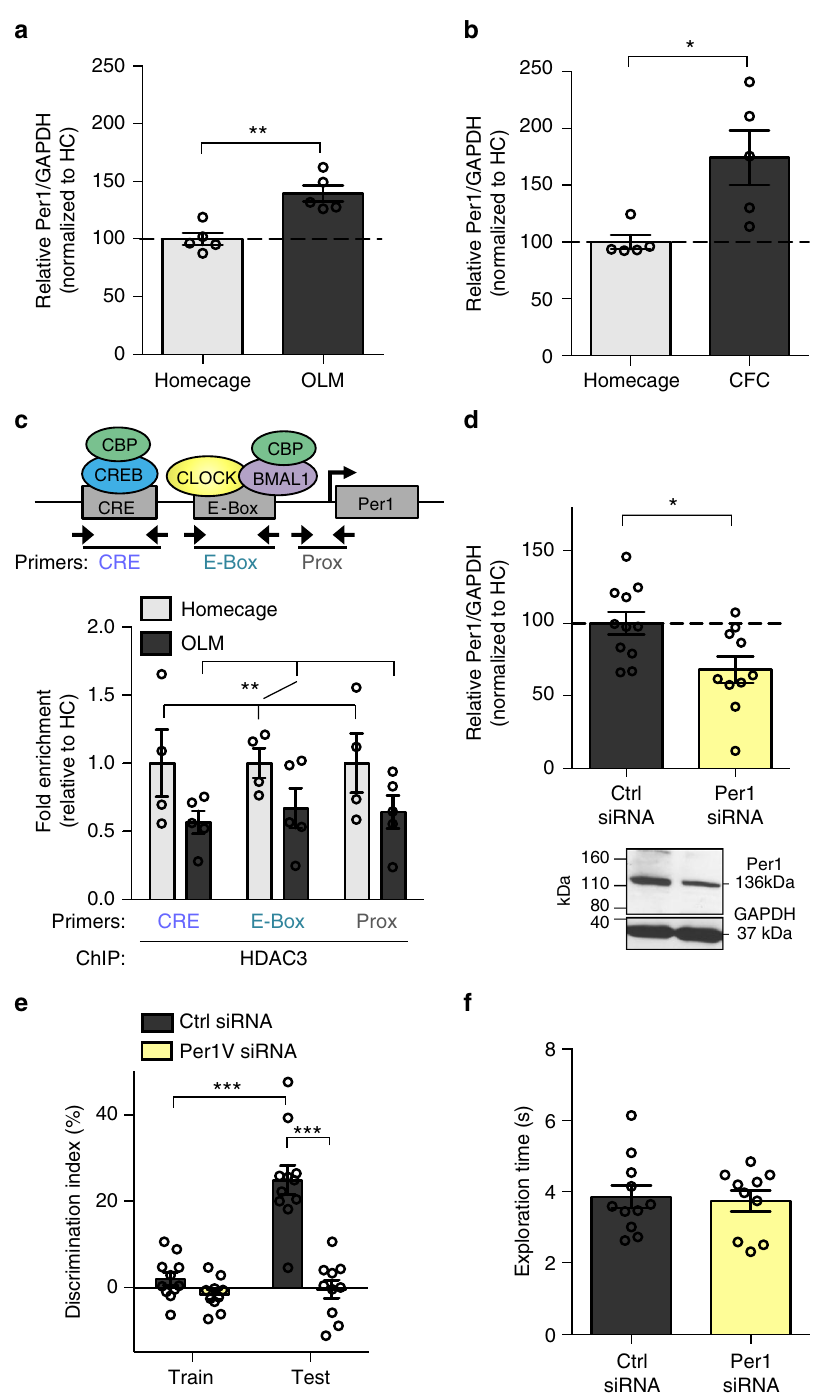
Fig. 4 Knockdown of PER1 in the dorsal hippocampus impairs long-term memory. Per1 mRNA expression is upregulated 60 m in the young hippocampus after a OLM ( t (8) = 4.49, ** p < 0.01; n = 5, 5; all male) and b context fear conditioning ( t (8) = 3.01, *p < 0.05, n = 5, 5; all male). c Top, schematic of ChIP primer sites along the Per1 promoter. Bottom, HDAC3 ChIP results. HDAC3 occupancy was reduced along the Per1 promoter in the young hippocampus after OLM (Training effect only, F (1,21) = 8.51, ** p < 0.01, n = 4, 5; all male). d Hippocampal PER1 protein expression was signi fi cantly reduced by Per1 siRNA infusion ( t (20) = 2.72, * p = 0.01, n = 11,11; all male). e Per1 knockdown impaired OLM (Two-way ANOVA: siRNA x Session ( F (1,19) = 29.22, p < 0.001), Sidak ’ s post hoc tests, *** p < 0.001, n = 11, 10; all male). f Per1 siRNA did not affect total exploration time at test ( t (19) = 0.27, p = 0.79). Data are presented as mean ± Following behavior, hippocampal tissue from a subset of animals was processed for RNA sequencing to con fi rm the presence of the pLVX-EV and pLVX-v5Per1 transcripts in the appropriate groups in vivo (Supplementary Fig. 7a, b, f, g).